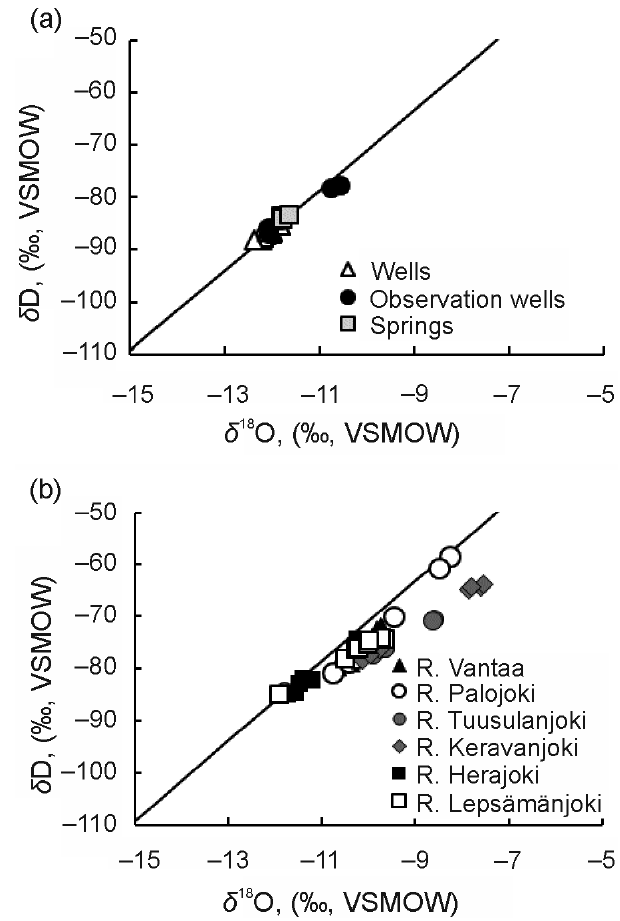
Figure 9. The δ 18 O and δ D values in the studied rivers: (a) the δ 18 O and δ D values of GW samples and (b) the δ 18 O and δ D values of RW samples. The data are shown against the local meteoric water line (LMWL) ( δ D = 7.67 δ 18 O + 5.79‰) defined by Kortelainen